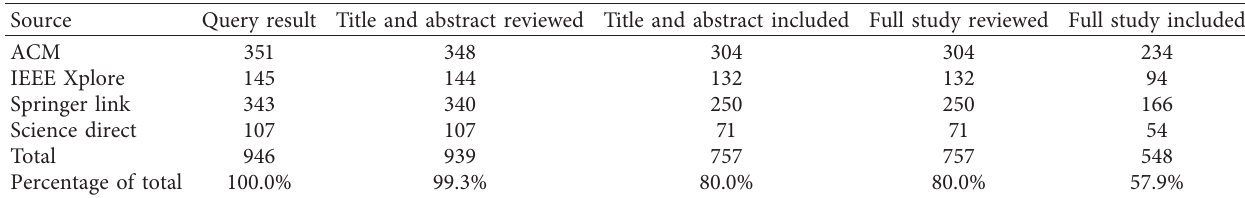
Figure 1: PRISMA flow diagram for this systematic literature review. Table 2: Distribution of studies by source.